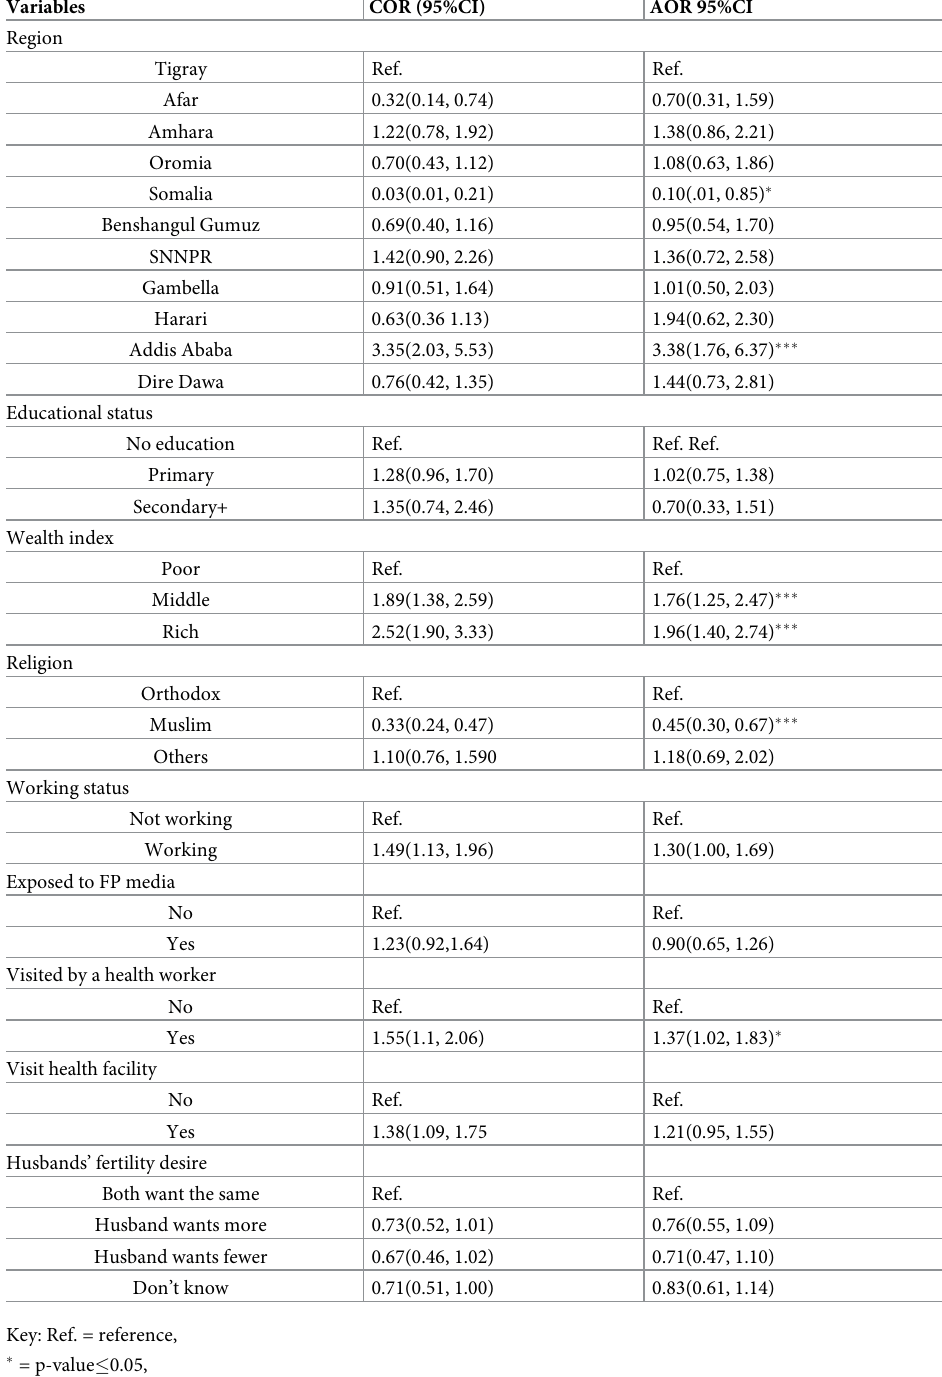
Table 3. Factors associated with contraceptives use among fecund married women who want no more children in Ethiopia, 2016